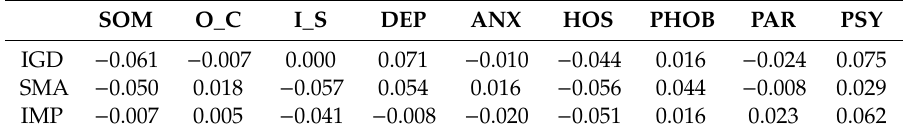
Table 5. Partial correlations between the variables of interest for the total sample.